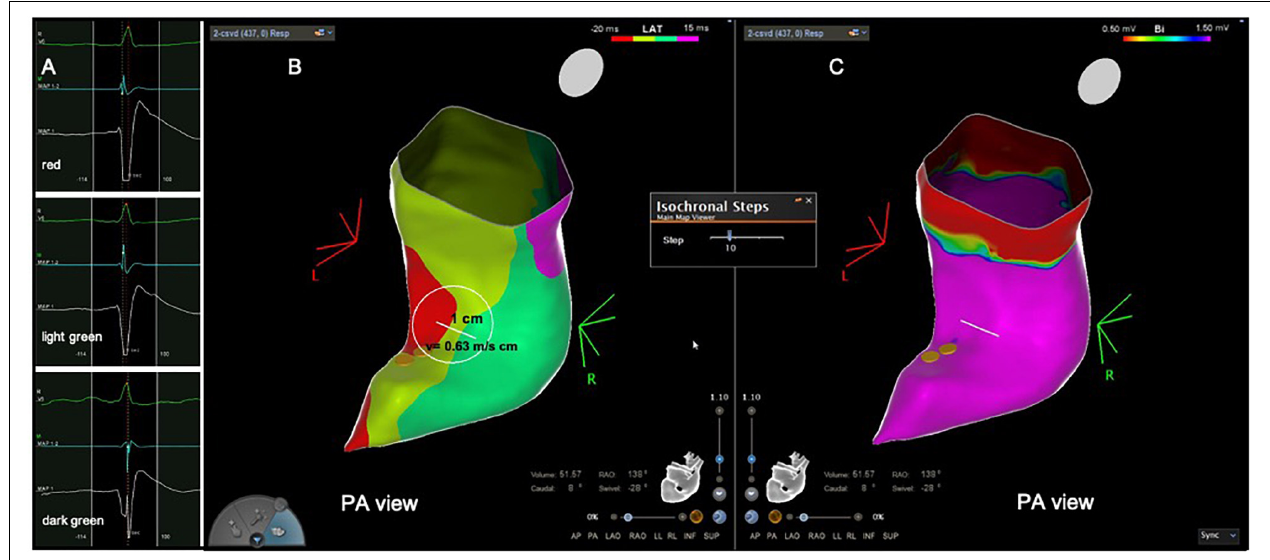
FIGURE 1 | Patient from the control group with normal activation and normal voltage. (A) Intracardiac electrograms corresponding to the respective isochrones presented in the isochronal map. (B) RVOT isochronal map in sinus rhythm without DZ. (C) Voltage map in sinus rhythm without LVAs. Yellow dots in (C) His bundle tagging. DZ, deceleration zone; LVA, low voltage area; RVOT, right ventricular outflow tract.